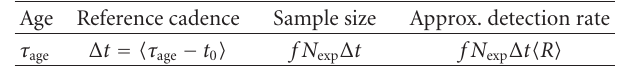
Table 1: For a desired detection age ( τ age ) we show a possible choice of cadence in days ( Δ t ), the maximum sample size consistent with this cadence, and the approximate detection rate if the suggested cadence and maximum sample sizes were used. t 0 corresponds to the time for the transient events to become visible since its occurrence; N exp is the number of observations per night, and R is the rate of events expected in each field. We assume that in all cases the time that a transient remains visible, τ , is bigger than the cadence chosen. For the opposite case, Δ t can be replaced by τ in the last two columns